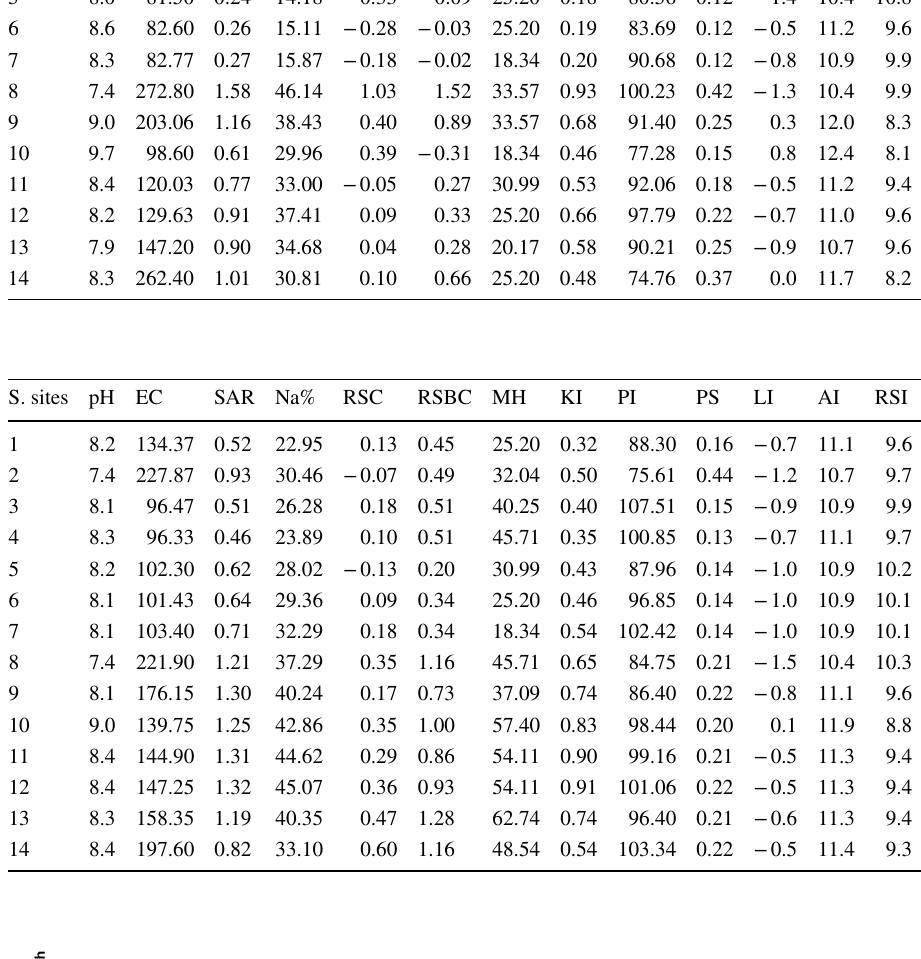
Fig. 8 USSL diagram of sam- ples of pre-monsoon